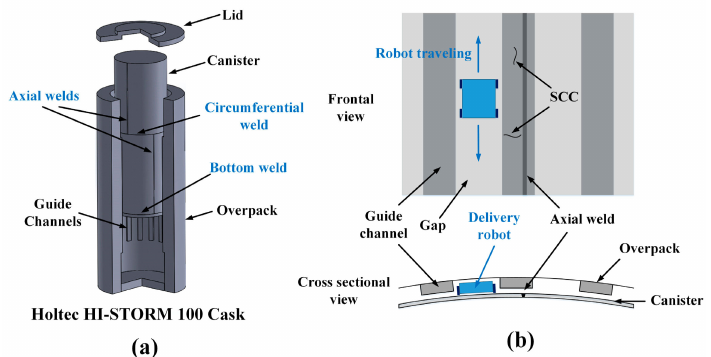
Figure 1. ( a ) A 3D cut-away view of the vertical-axis HI-STORM 100 cask; and ( b ) the frontal view